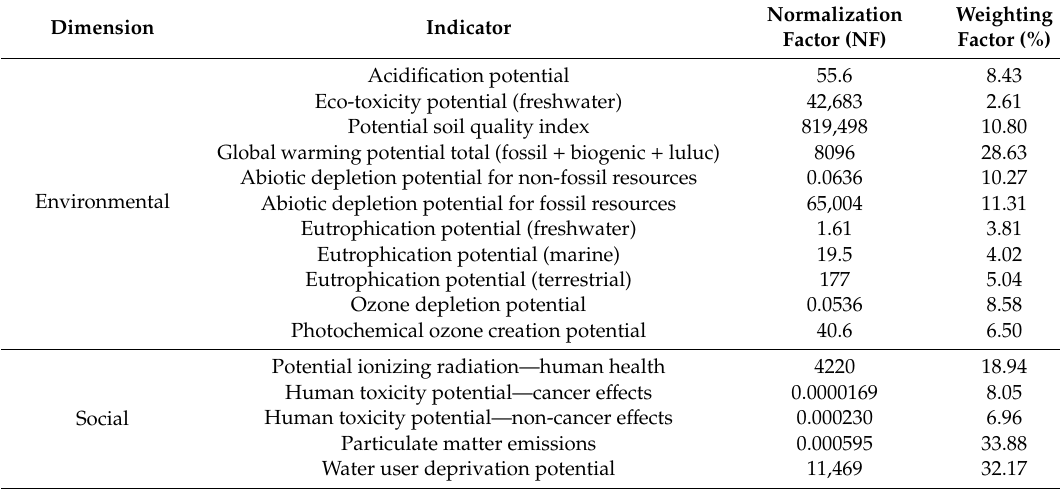
Table 2. Normalization and weighting factors used for environmental and social indicators